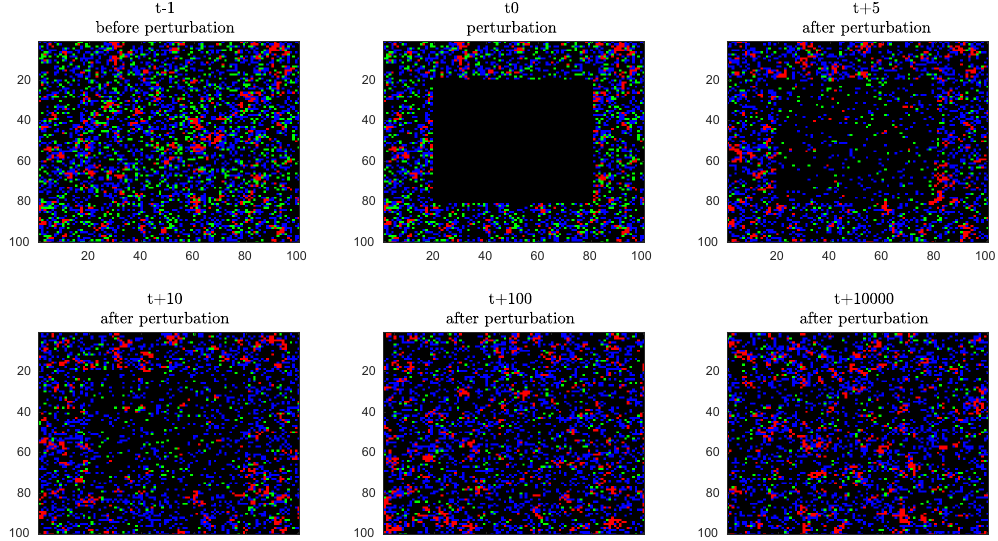
Figure SI.10. Maintenance of mutualism in the face of a reduction in competition caused by a perturbation creating a large square of free cells. Snapshot at several times: t − 1 is the eco-evolutionary equilibrium with mutualism just before the perturbation, then at t 0 the perturbation, and then t + 5 , t + 10 , t + 100 and t + 10000 after the perturbation. In black, the free cells; in green, the hosts alone; in blue, the couples with parasitic symbionts; and in red, the couples with mutualistic symbionts. Parameters are m = 0 . 06 , c m = 0 . 3 , w h = 1 , γ C = 0 . 2 , f h = 0 . 1 , f s = 2 . 5 , f max = 8 , f a = 0 . 5 , β max = 0 . 5 and d = 0 . min min